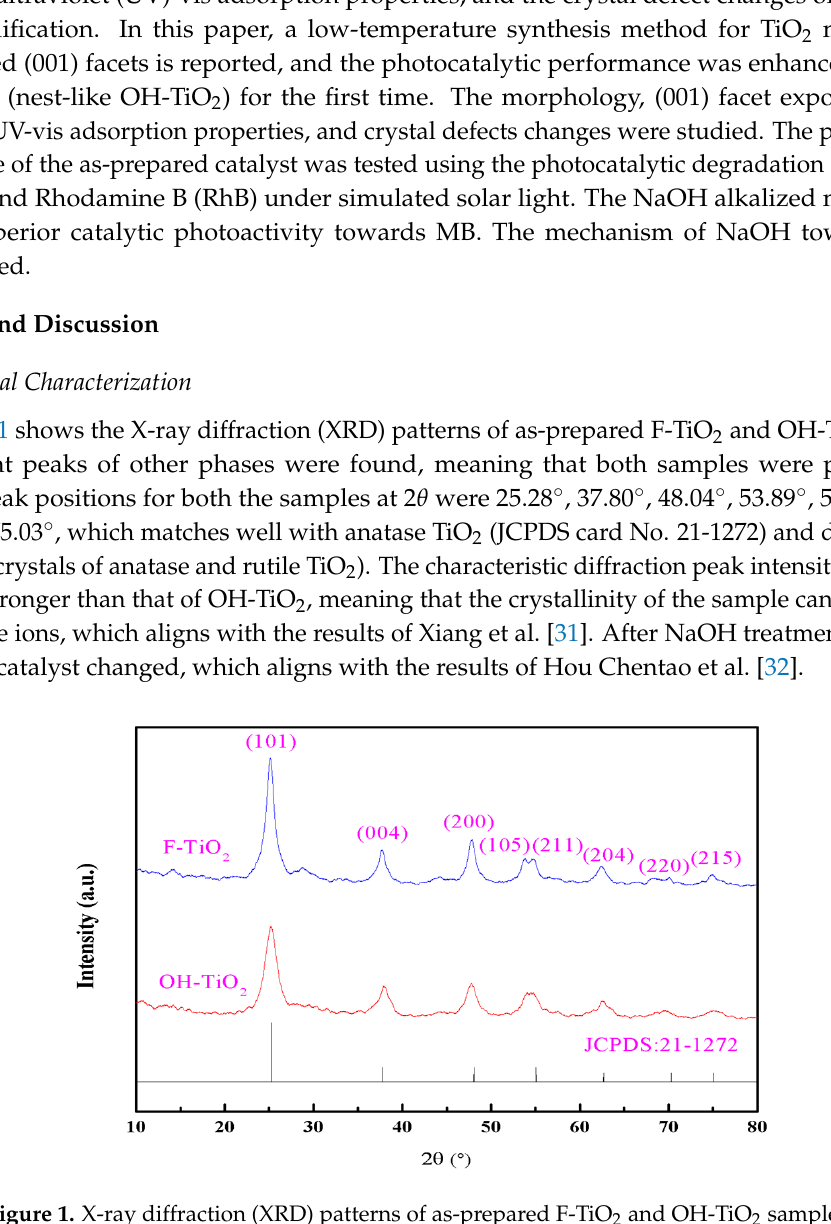
Figure 2 . Field emission Scanning electron microscopy (FE ‐ SEM) and high ‐ resolution transmission electron microscope (HRTEM) of as ‐ prepared F ‐ TiO 2 and OH ‐ TiO 2 samples. ( a ) FE ‐ SEM images of F ‐ TiO 2 ; ( b ) FE ‐ SEM images of OH ‐ TiO 2 ; ( c , d ) HRTEM images of F ‐ TiO 2 ; ( e , f ) HRTEM images of OH ‐ TiO 2 . Raman spectroscopy was used to calculate the percentage of (001) facets of the as ‐ prepared catalysts (Figure 3). The percentage of (001) facets was calculated using the peak intensity ratio of the Eg and A1g peaks at 144 cm − 1 and 514 cm − 1 , respectively [27,37]. The percentage of (001) facets for F ‐ TiO 2 was 27.8%, but after modification with NaOH, the percentage of OH ‐ TiO 2 increased to 39.2%, which helped to enhance the photocatalytic performance of catalyst.